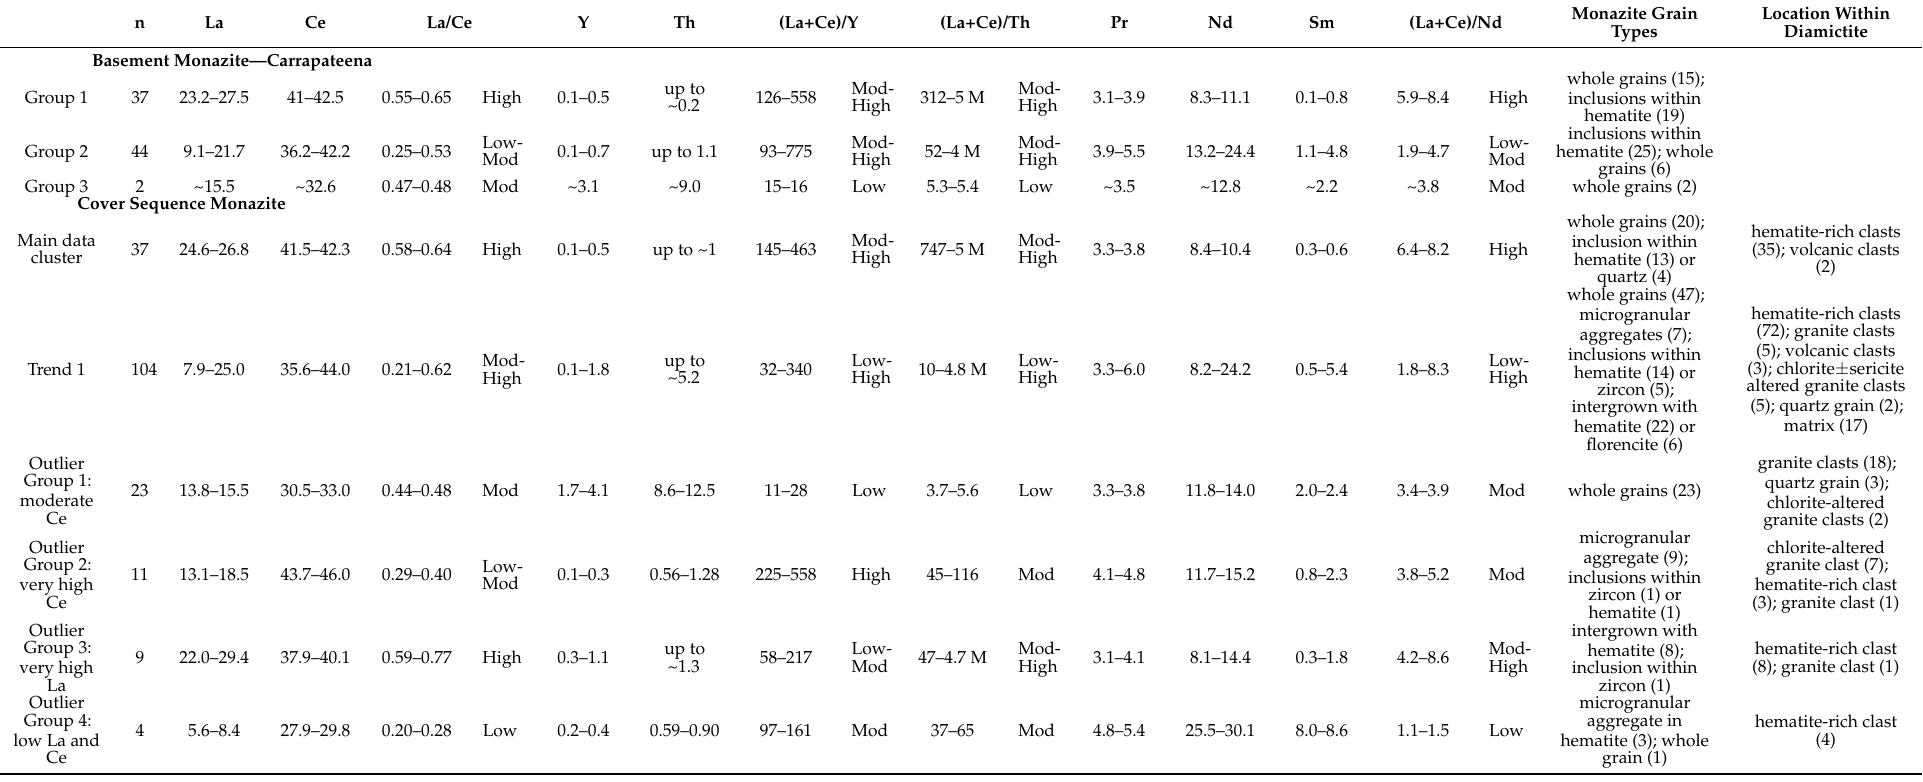
Table 2. Chemistry of selected elements of monazite grains from Carrapateena basement and overlying basal cover sequence diamictite. Patterns of ratios of La/Ce, (La + Ce)/Y, (La + Ce)/Th and (La + Ce)/Nd are highlighted in dark grey. Details on monazite grain type and location within the diamictite are given.